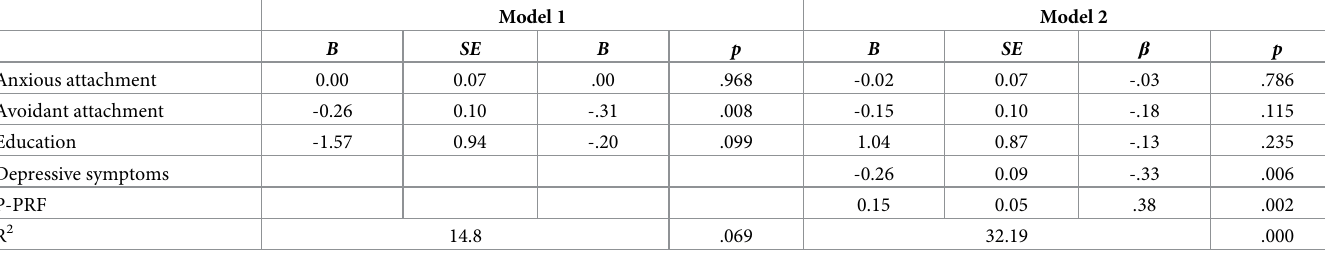
Table 4. Multiple regression results for MAAS quality of